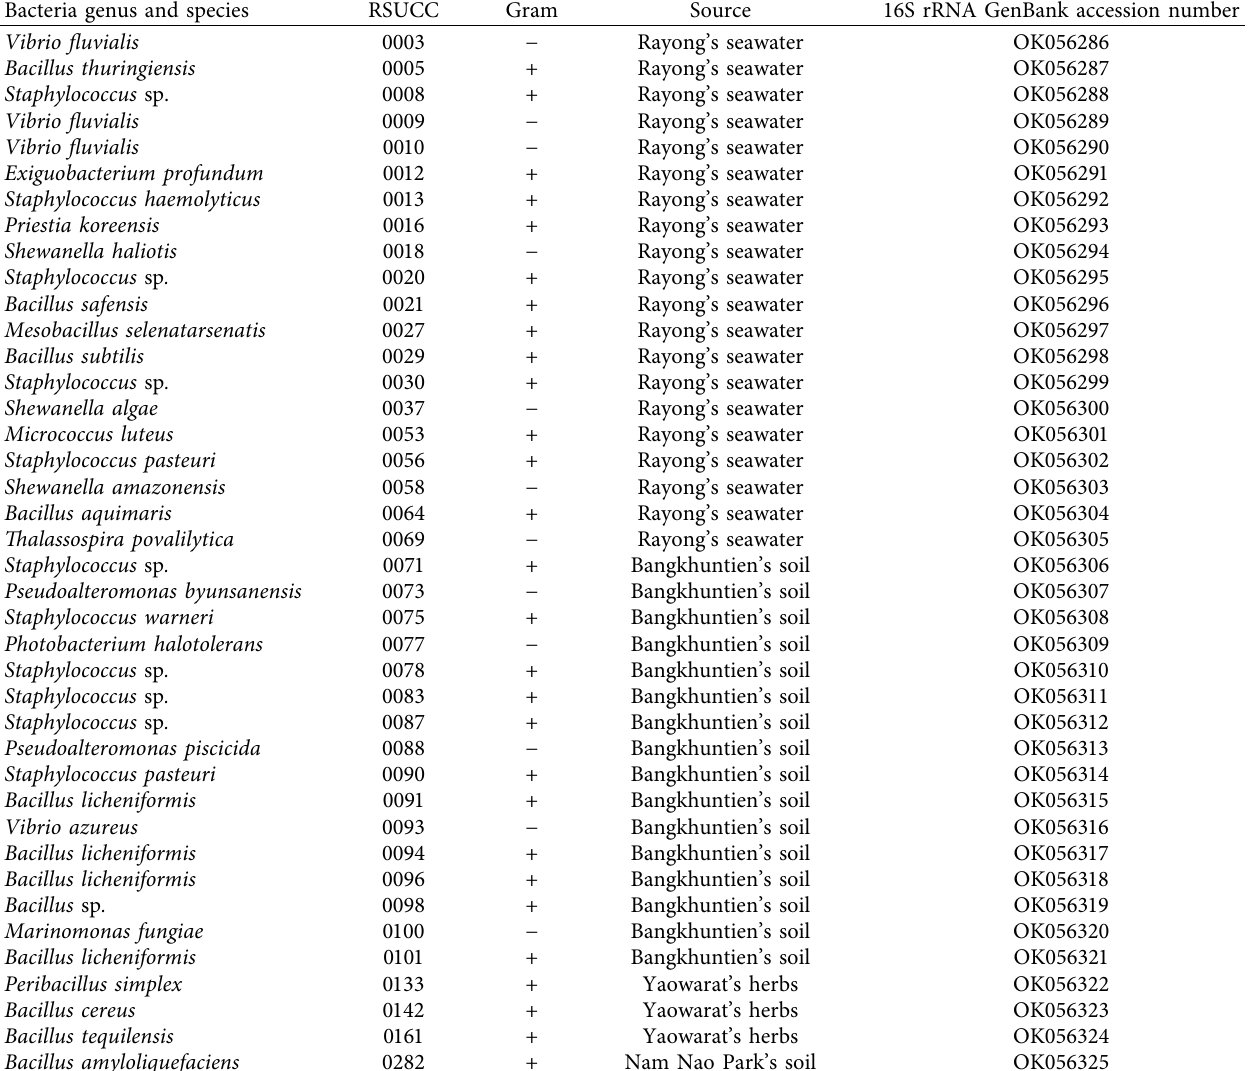
Table 1: Forty bacterial strains isolated and identified from Thailand’s natural resources in the current